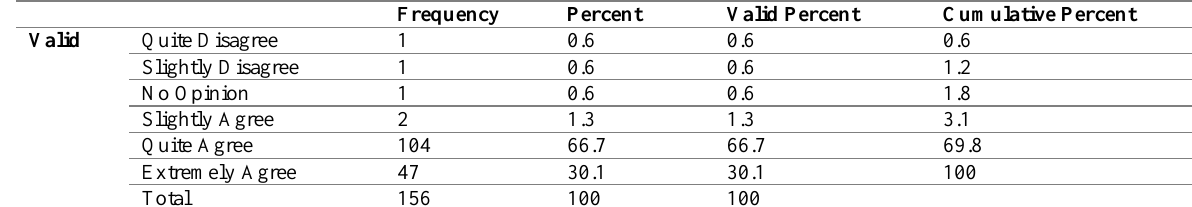
Table 5: Perceived ease of use of MyCO system